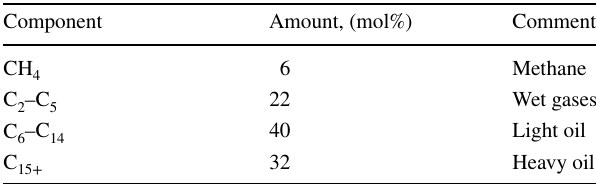
Table 7 Component composition of pyrolysis products for the